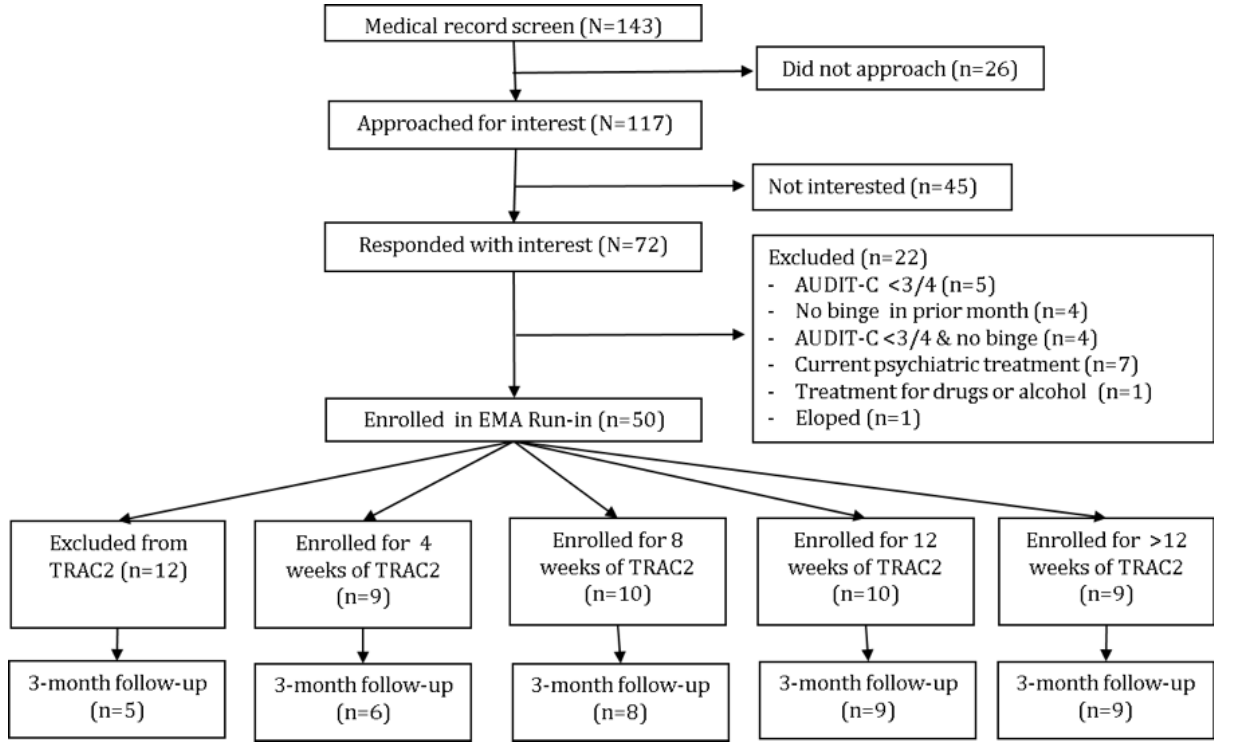
Figure 1. CONSORT diagram (EMA, ecological momentary assessments; AUDIT-C, Alcohol Use Disorder Identification Test for Consumption; TRAC2, Texting to Reduce Alcohol Consumption